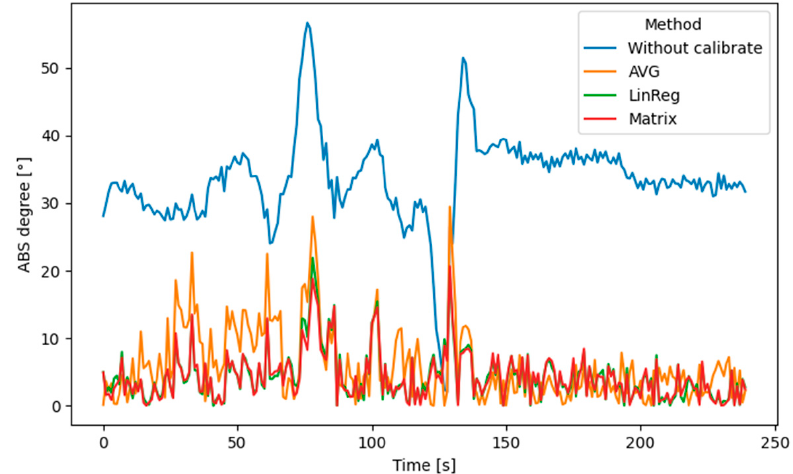
Figure 5. The absolute error of determining magnetic north. The prediction of the position, with different types of search for calibration constants, can be seen in Figure 6, where the magnetometer was calibrated for 4 min, and then the position of the vehicle was predicted for 4 min. The direction of the uncalibrated data (red color) was almost always in the same direction. This phenomenon was caused by the car’s hard ferromagnetic material. The absolute value of the measured vector was around 120 µ T, while the intensity of the magnetic field in the measurement locations was 49.5 µ T. At the end of each measurement, we placed a compass at the location of the sensor and recorded its value. This coincided with the information from the uncalibrated magnetometer. The magnetic field in the car is different in every place. When measuring with a compass in several places in the vehicle, the needle is always pointed in a different